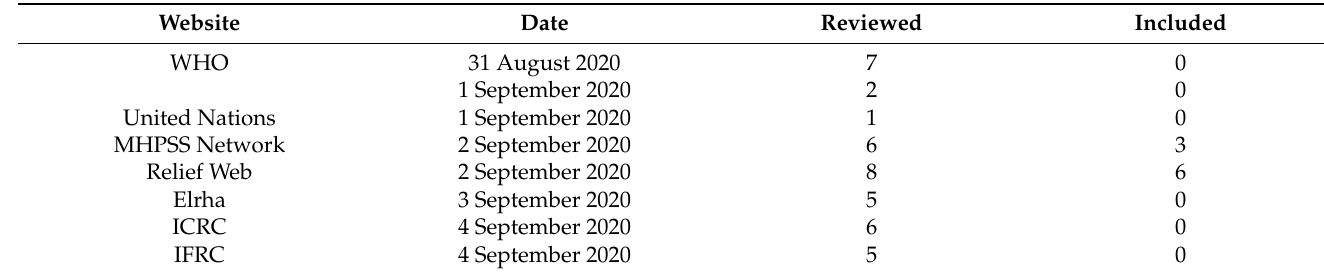
Table 2. Grey literature search *.